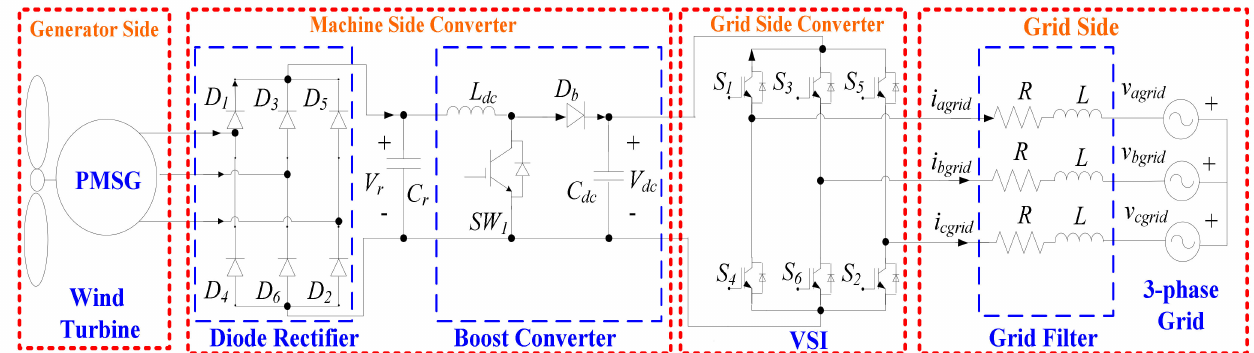
Figure 2. Schematic diagram of considered PMSG-based